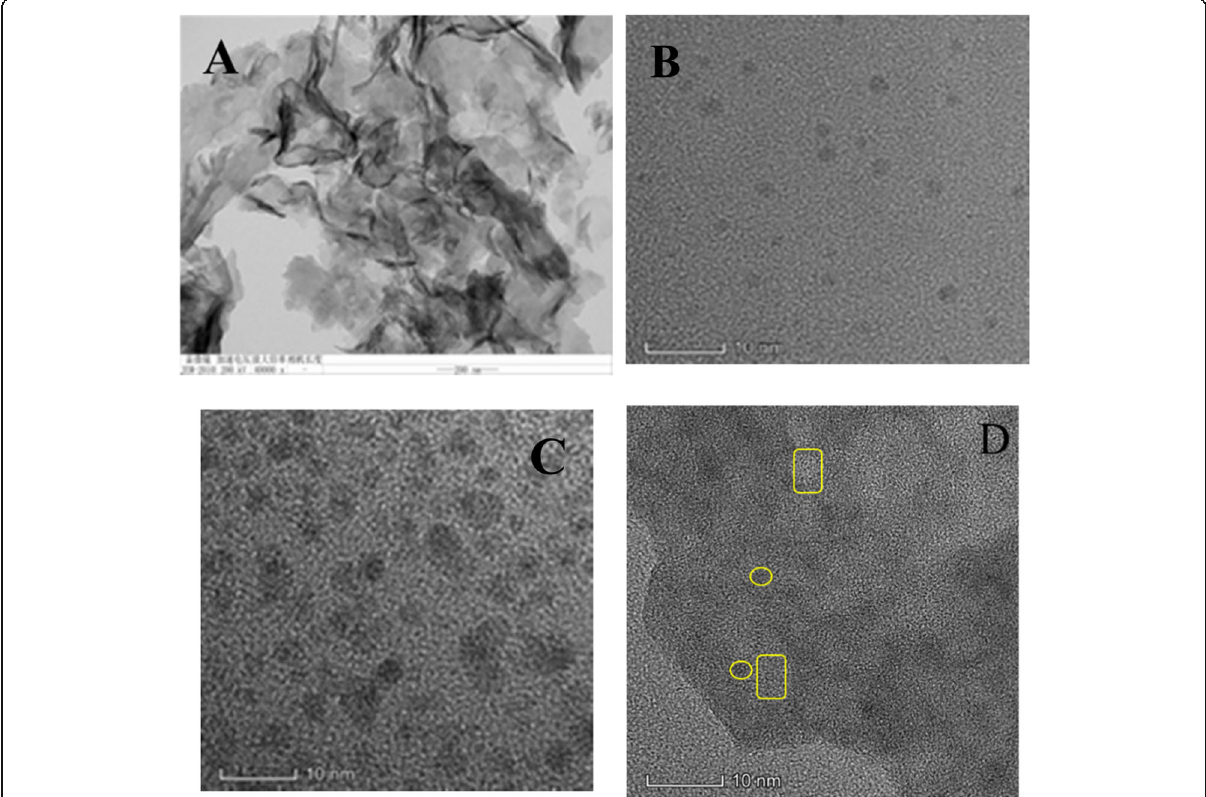
Fig. 3 HRTEM images of a g-C 3 N 4 nanosheets, b C QDs, c N – C QDs and d N – C QDs/g-C 3 N 4